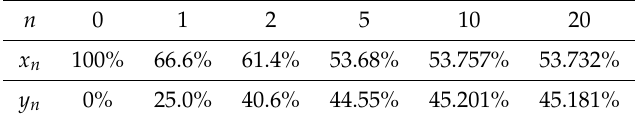
Table 13. Values of the iterated sequence ( x n , y n ) if started with ( 100%,0% ) . n 0